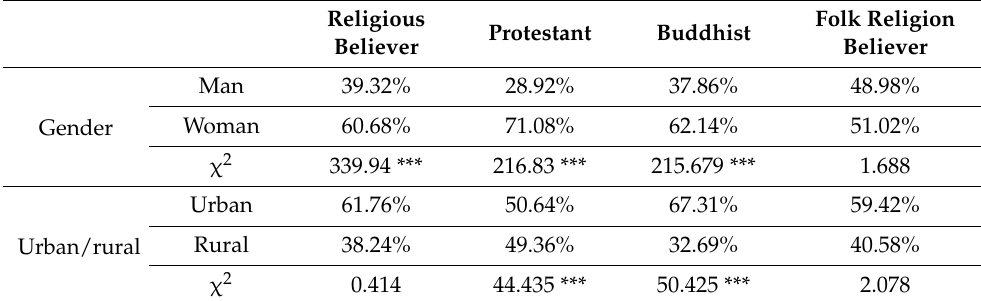
Table 2. Bivariate analysis of the “Five types” (I).